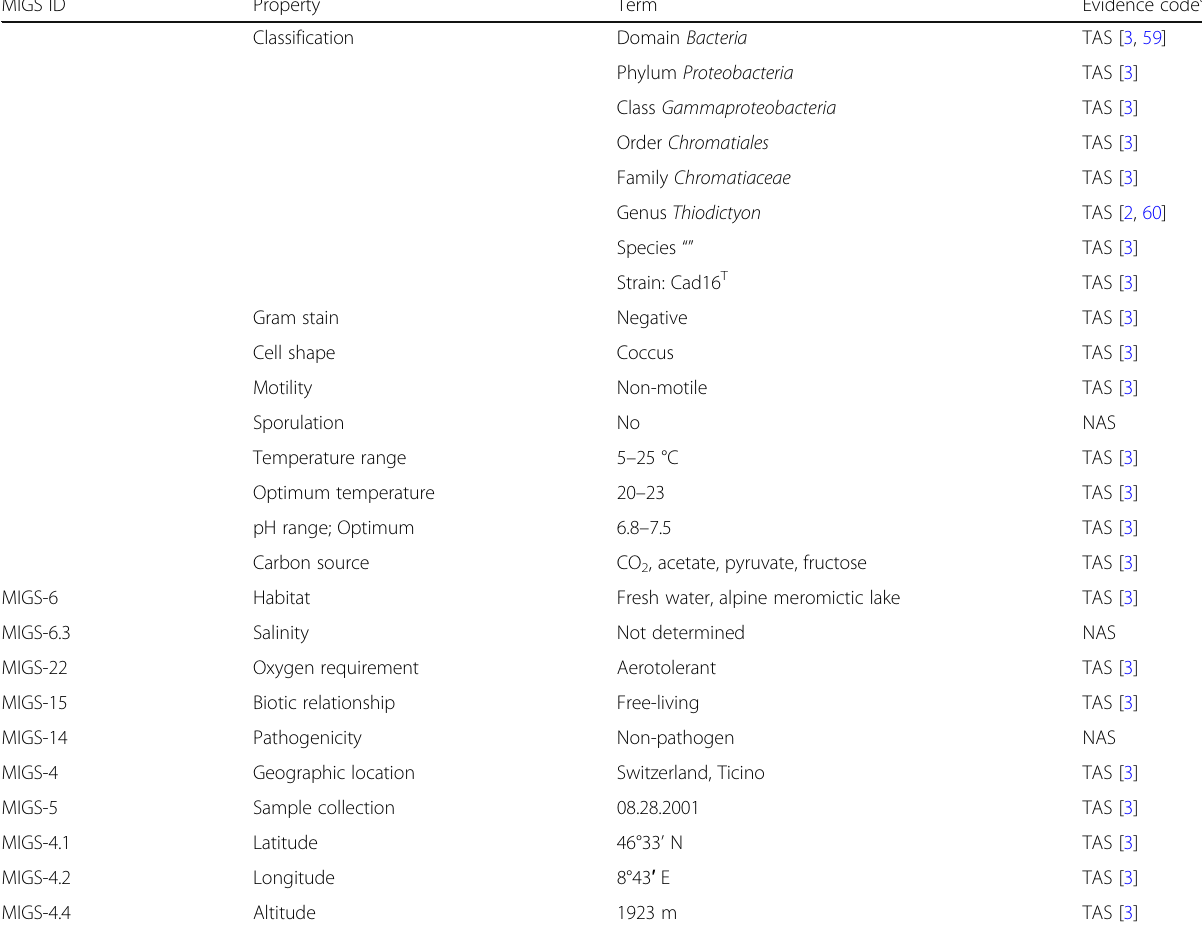
Table 1 Classification and general features of “ T. syntrophicum ” sp. nov. strain Cad16 T according to the MIGS recommendations